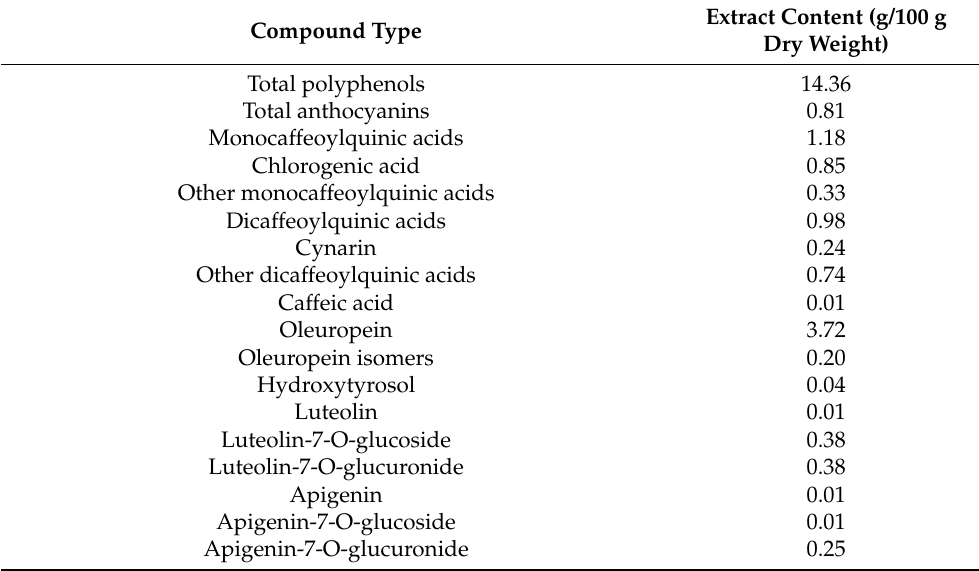
Table 1. Chemical characterization of whole TOTUM-63 powder. Reprinted with permission from ref. [17] Copyright 2021